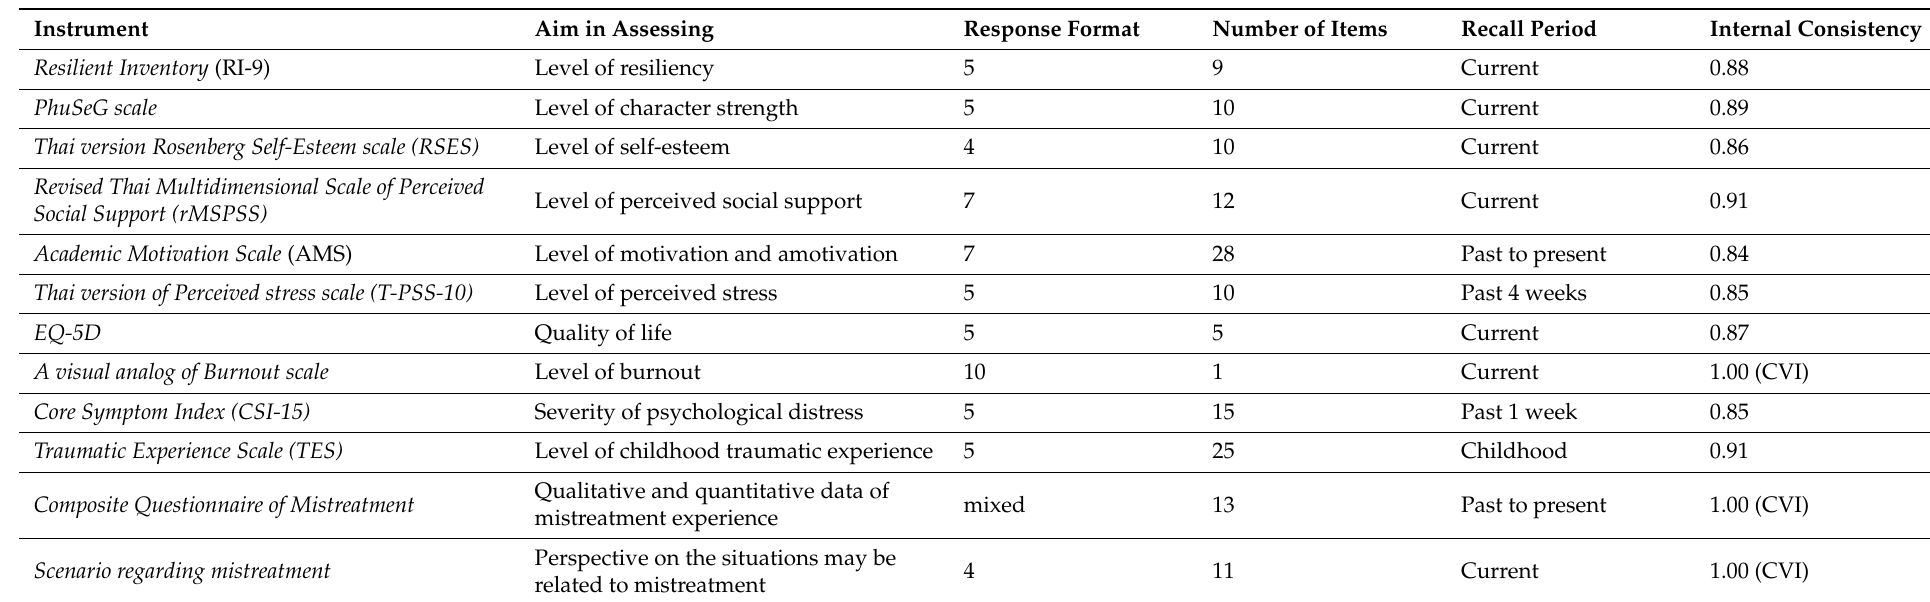
Table 2. Measurement tools of the